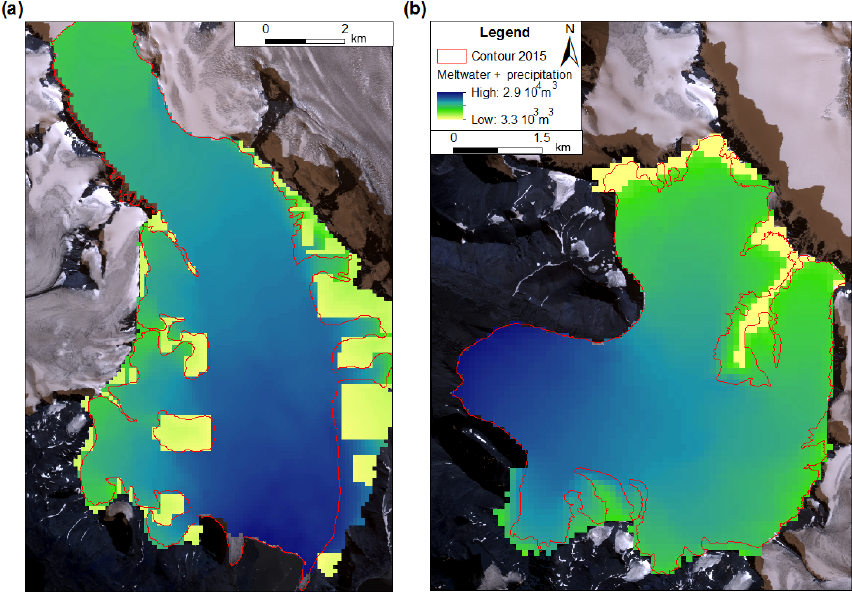
Figure 3. Spatial water recharge (meltwater and precipitation) for Hansbreen (a) and Werenskioldbreen (b) in 2015. The map background is a WorldView-2 VHRS image acquired on 21 August